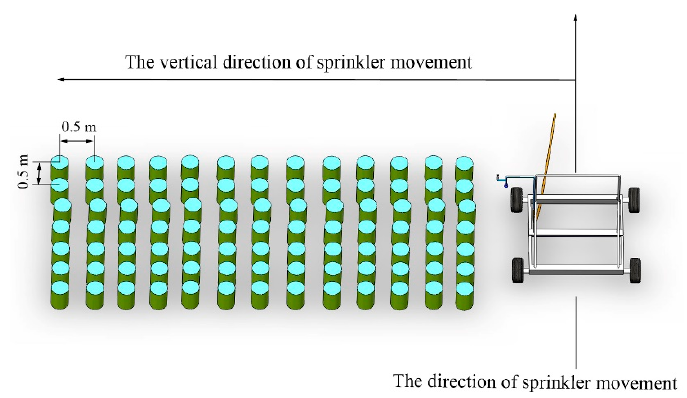
Figure 5. The test layout of a single moving sprinkler.